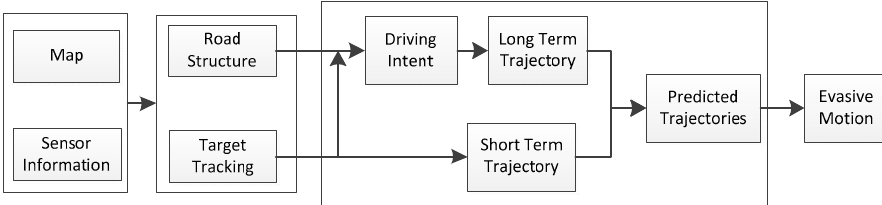
Figure 1. Structure of the collision avoidance method. Driving intent estimation and trajectory prediction are the two main components of this method.